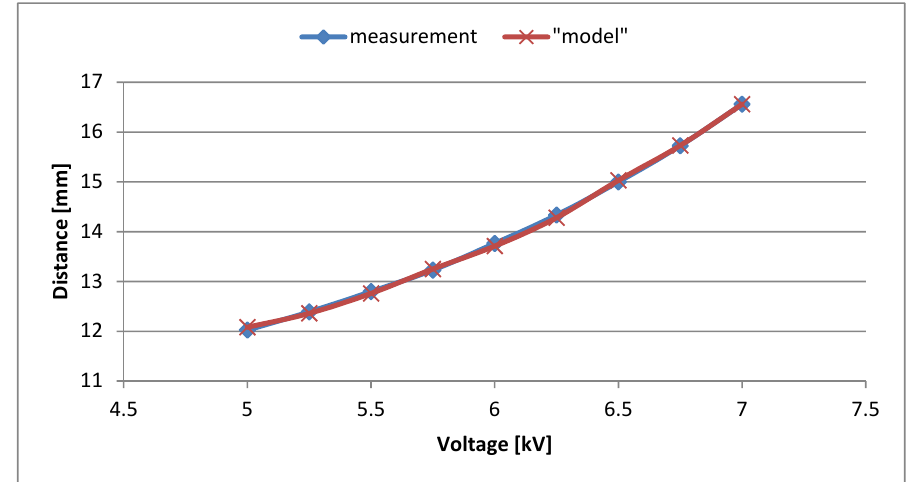
Figure 5. Comparison of membrane distances for static load force 1.03 [N]. Table 4. The comparison of the displacements for different voltage supply and load force 1.23[N].